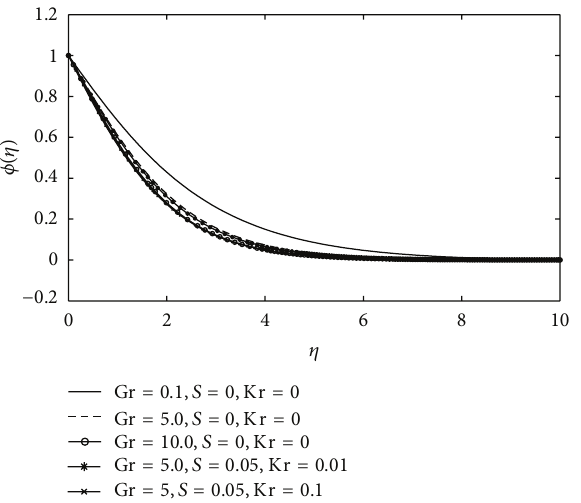
Figure 17: Concentration profiles for different values of Gr, 𝑆 , and Kr for Ha = 0.1 , Gc = 0.1 , Sc = 0.62 , Bi = 0.1 , Nc = 0.01 , and Pr = 0.72 .